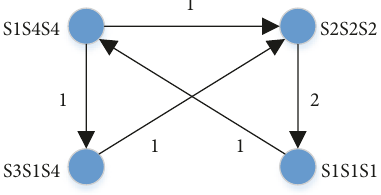
Figure 2: Sample directed weighted